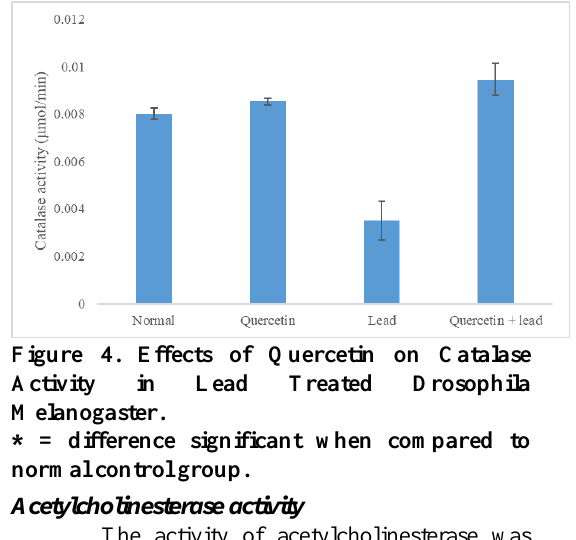
Figure 4. Effects of Quercetin on Catalase Activity in Lead Treated Drosophila Melanogaster.